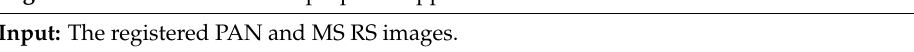
Figure 12. Flow chart of MS-Pansharpening algorithm in this paper. The implementation process of the Algorithm 1 is as follows: Algorithm 1 Procedures of the proposed approach.